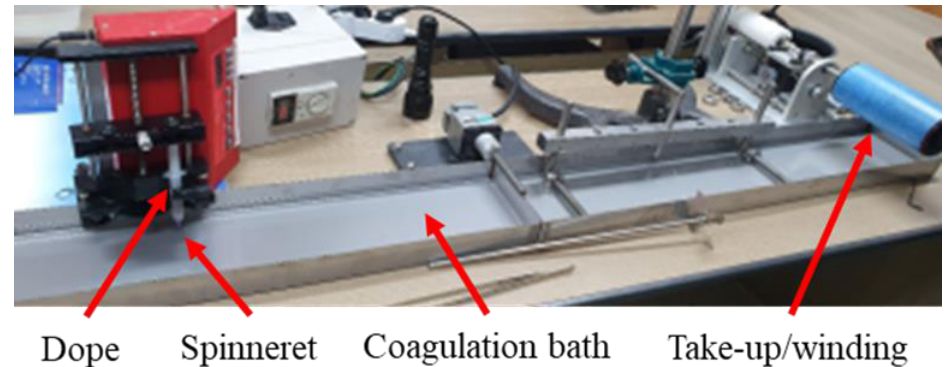
Figure 2. Lab-scale equipment of collagen fiber spinning.